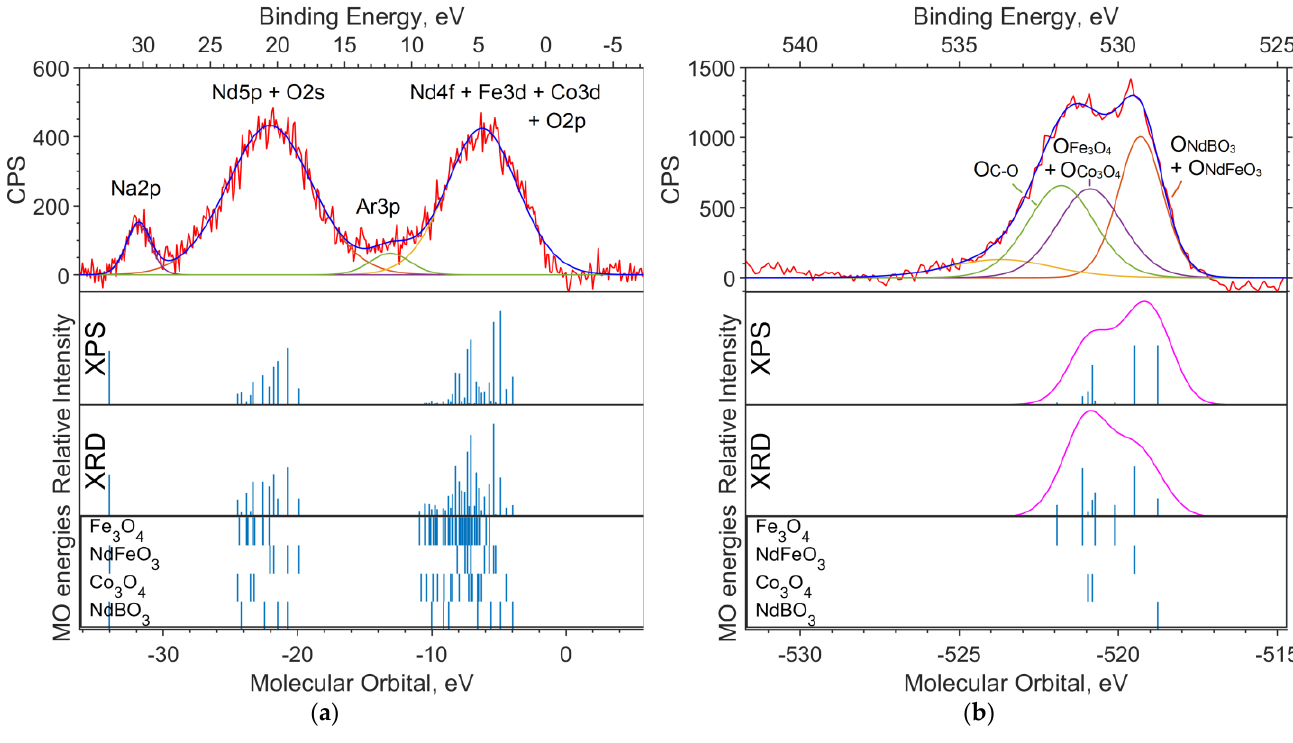
Figure 7. ( a ) XPS spectrum of the valence region and ( b ) spectrum of oxygen 1s levels for the NdFe (1 − x) Co x B oxide powders with x = 0.5. The theoretical spectrum intensities based on the XPS (top) and the XRD (bottom) concentrations, and the MO energies of model compounds with Gaussian functions with a half-width FWMH = 1.5 eV are superimposed on the theoretical intensities on ( b ).